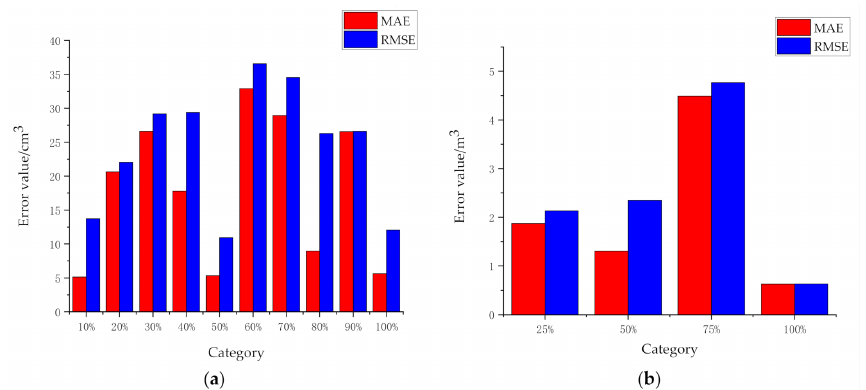
Figure 11. Model performance index histogramt: ( a ) Data in a laboratory environment; ( b ) Data in an open-pit